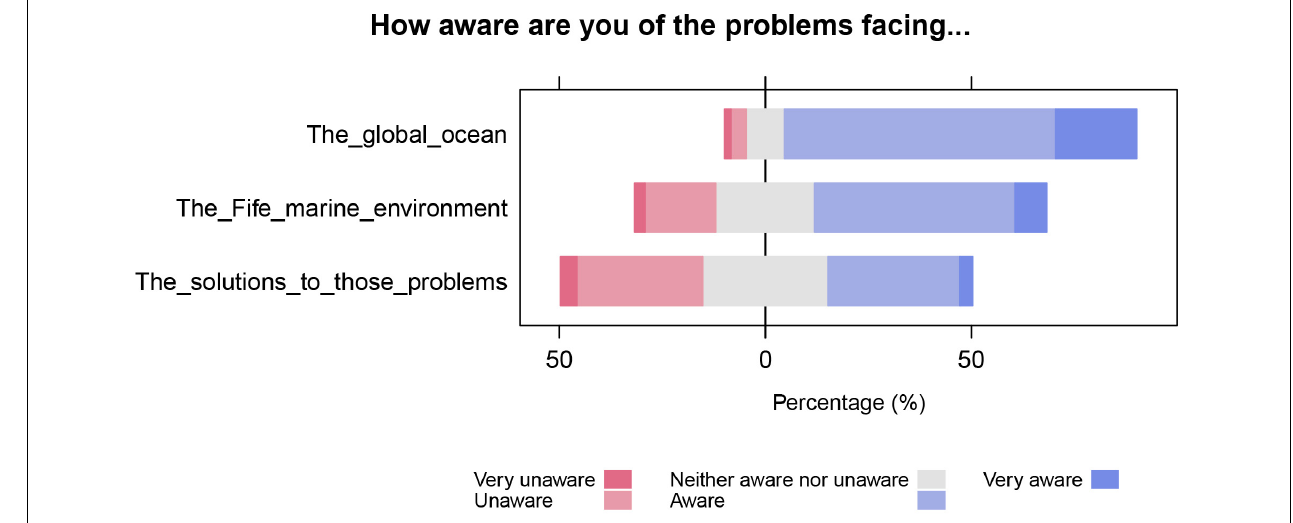
FIGURE 2 | Awareness of global problems, local problems, and solutions to those problems ( n =